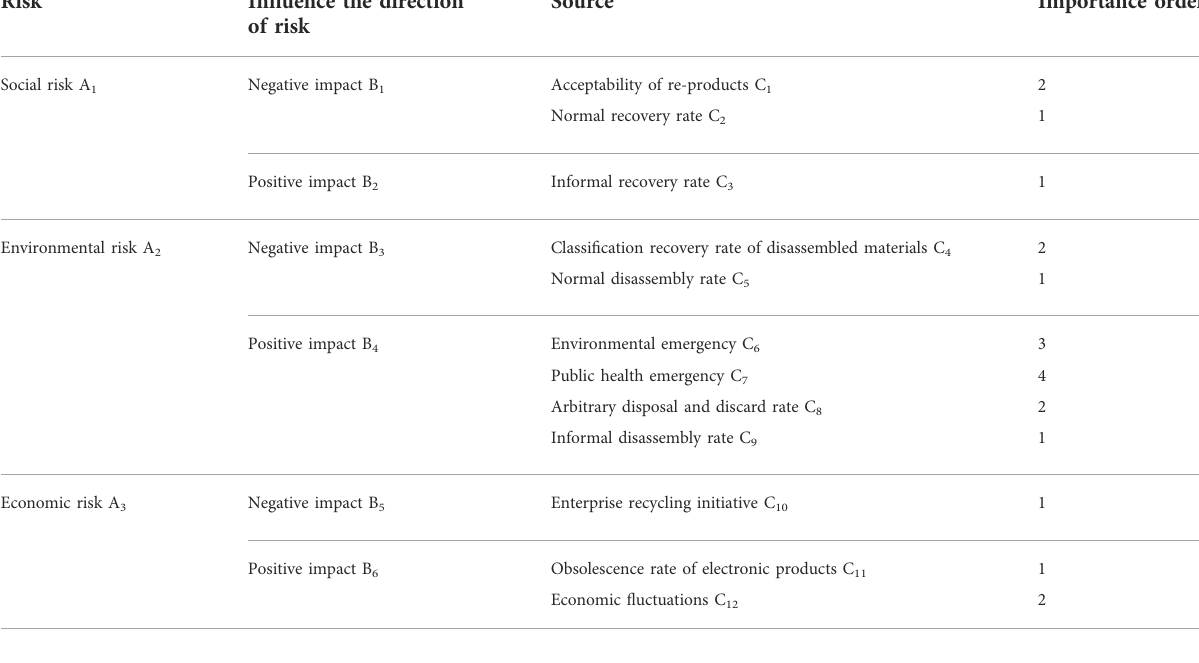
TABLE 1 Index sources and importance ranking of risks.